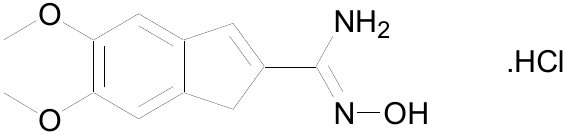
Figure 3. Structure of N -hydroxy-5,6-dimethoxy-1 H -indene-2-carboximidamide.HCl.